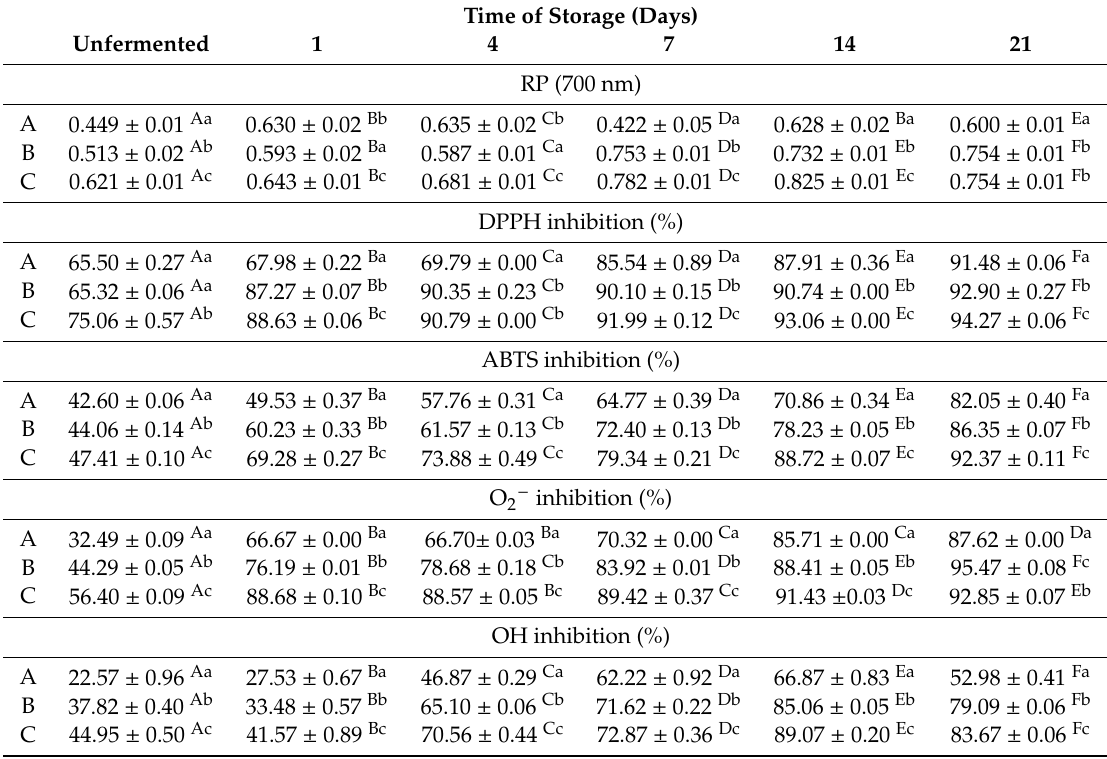
Table3. Reducigpower(RP),2,2-diphenyl-1-picrylhydrazyl(DPPH),2,2 (cid:48) -azino-bis(3-ethylbenzothiazoline- 6-sulfonic acid) (ABTS), O 2 − , and · OH radical scavenging activity of fermented beverages and unfermented (control)